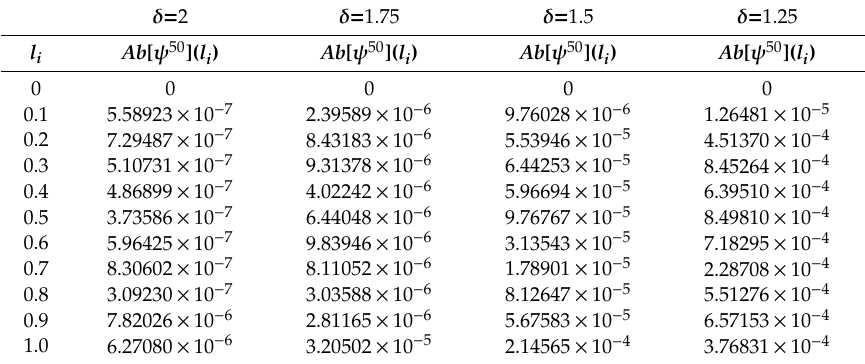
Table 1. Numerical results of Example 1 using RKDM.